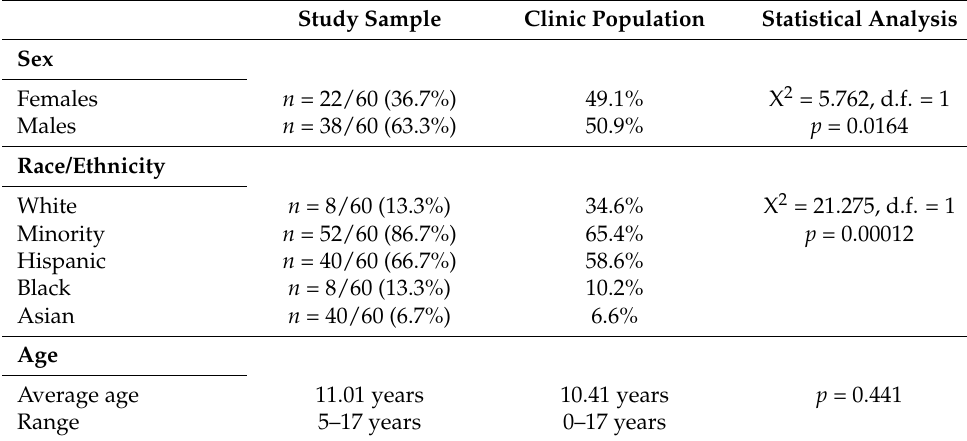
Table 1. Demographic analysis of study